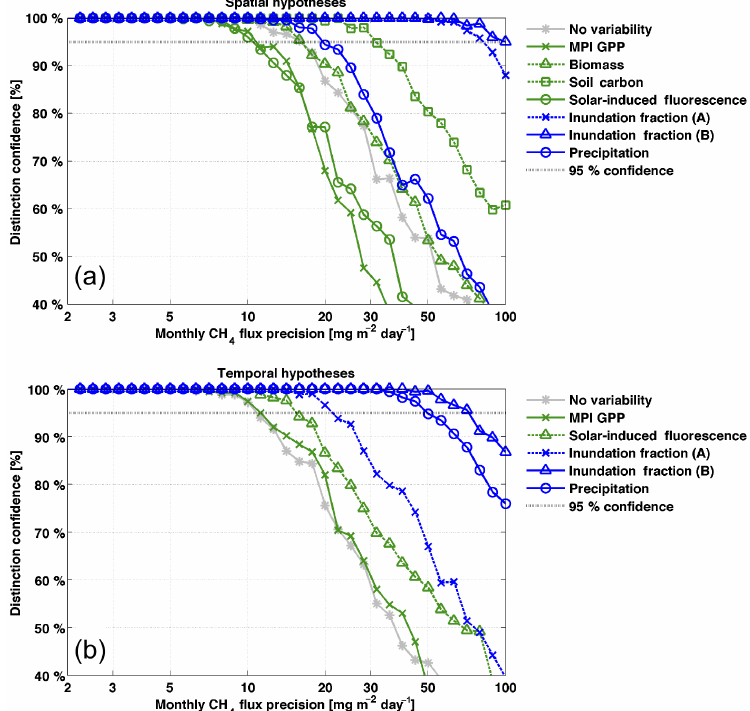
Figure 4. Distinction confidence between Amazon basin spatial and temporal wetland CH 4 emission hypotheses against monthly ∼ 333km CH 4 flux precision. Spatial and temporal wetland CH 4 emission hypotheses are distinguishable with a 95% confidence at a ≤ 10mgm − 2 day − 1 precision. For this study we define our ∼ 333km CH 4 flux precision requirement as 10mgm − 2 day − 1